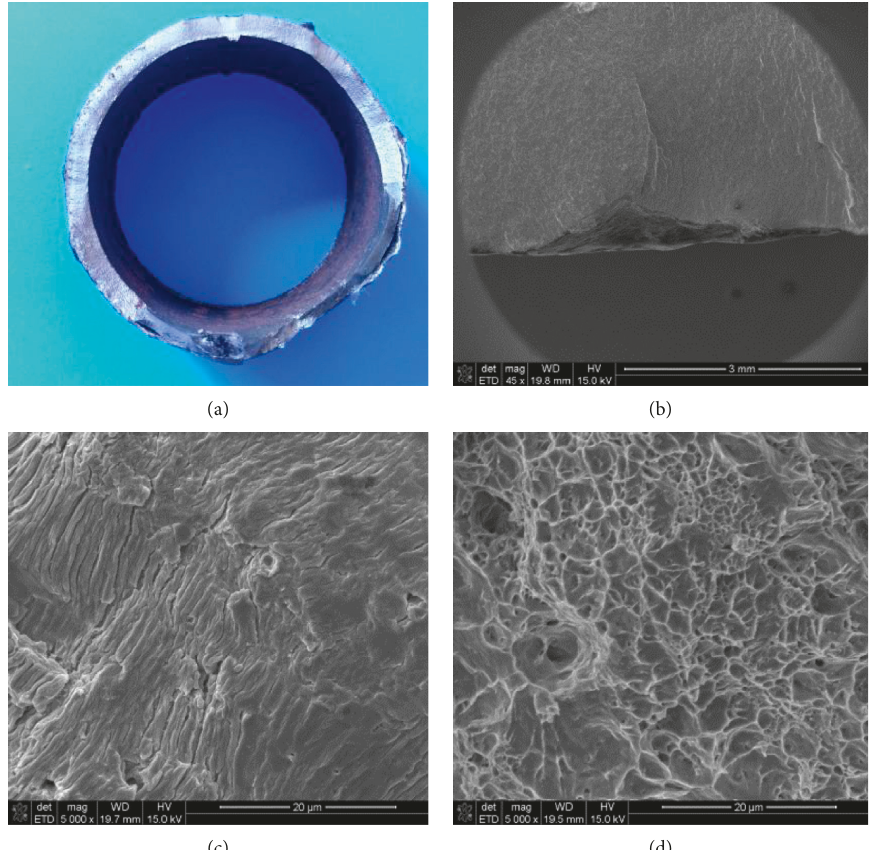
Figure 14: Typical fracture images (stress amplitude � 155MPa and stress ratio � 0). (a) Macroimage. (b) Micrograph of fatigue initiation zone. (c) Micrograph of fatigue crack propagation zone. (d) Micrograph of fast fracture